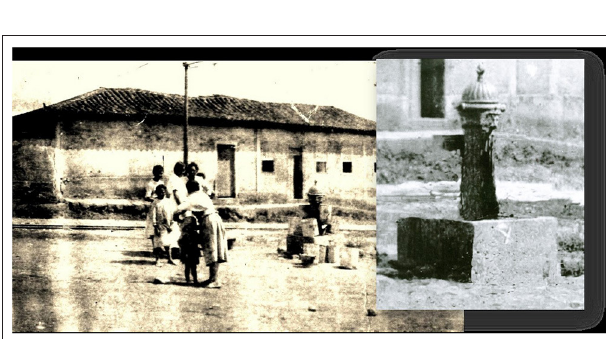
FIGURE 5 | Public fountain installed in 1885 at Praça Dr. Jorge. Source: Renato Libeck’s personal archives.